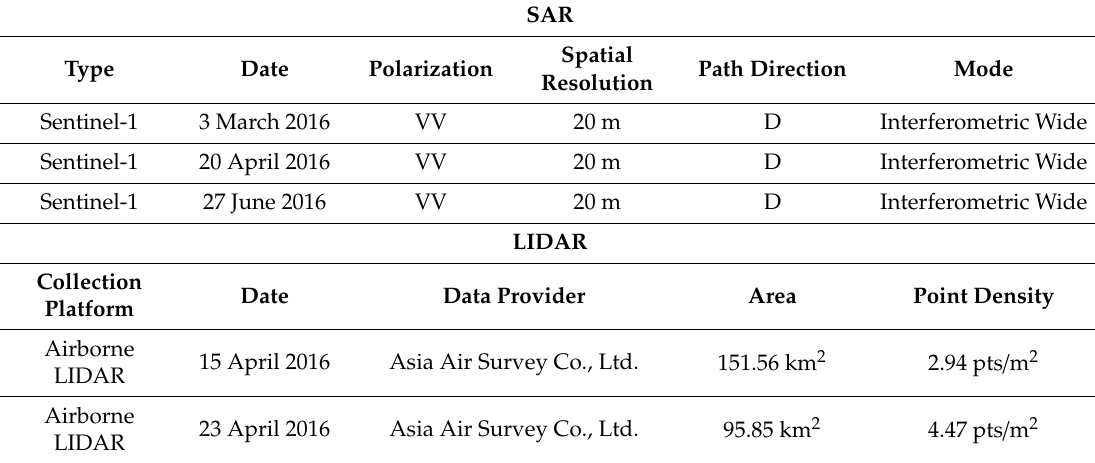
Figure 2. Location of the pre-event ( a ) and post-event ( b ) DSMs and study area. DSMs acquired by Asia Air Survey Co., Ltd. (Tokyo, Japan) [20,21].